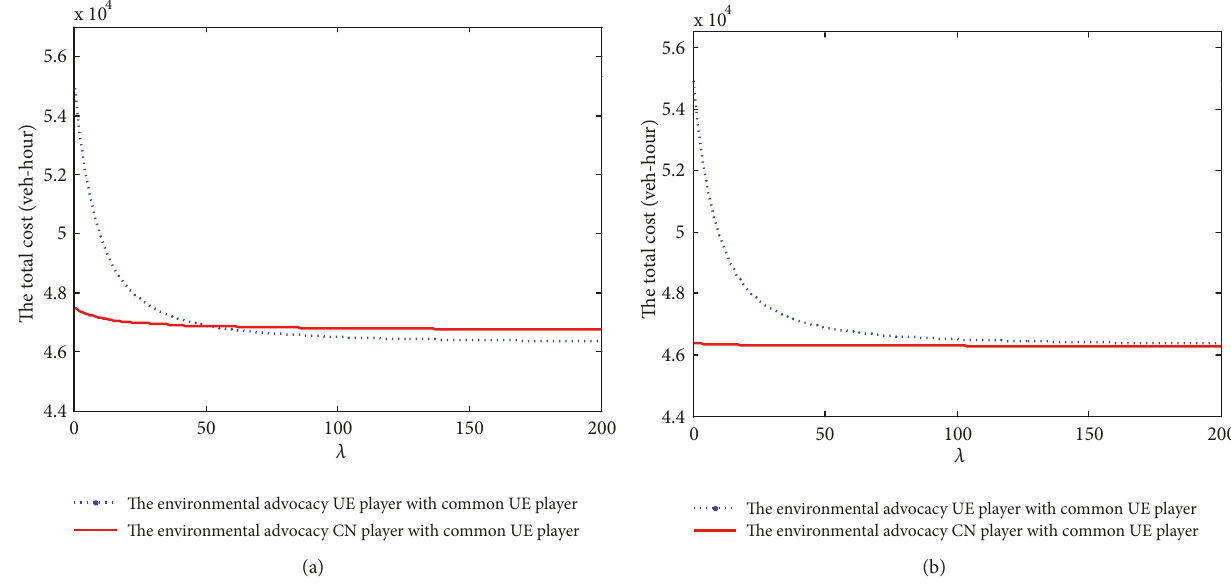
Figure 7: Comparison of case 2 and case 3 in total cost (( ∑ 𝑎 [𝑡 𝑎 ( V 𝑎 ) + ̃𝜏 𝑎 ( V 𝑎 )] )): (a) total cost when 𝜃 = 0.5 and (b) total cost when 𝜃 = 0.7 .